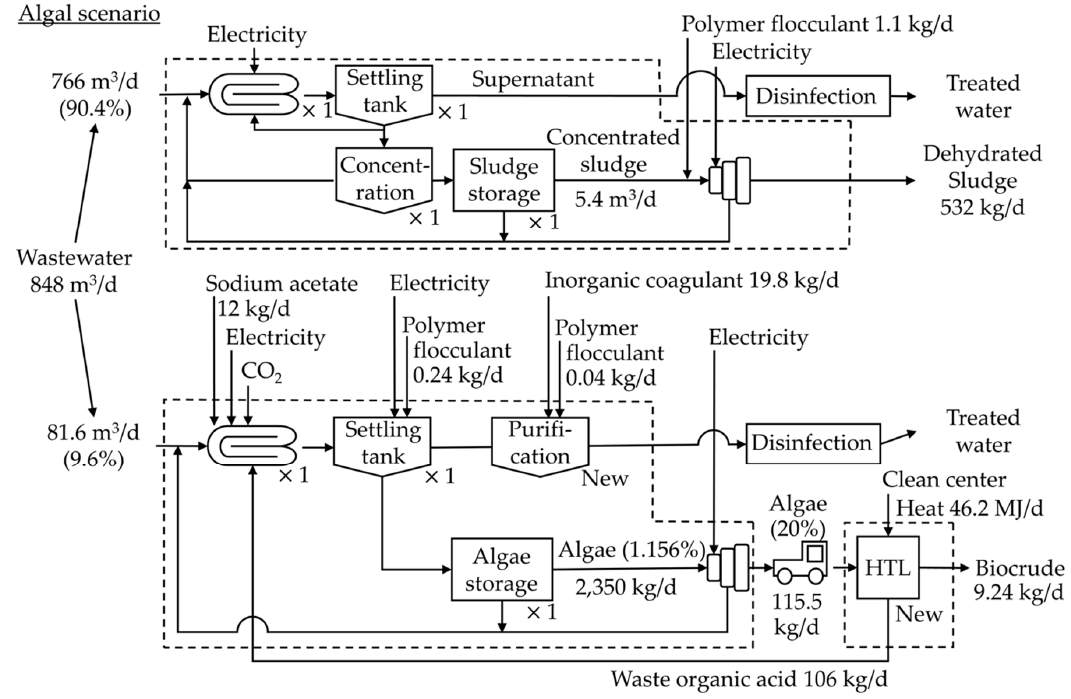
Figure 6. Introduction of the microalgae oil production system at Awano WWTP.